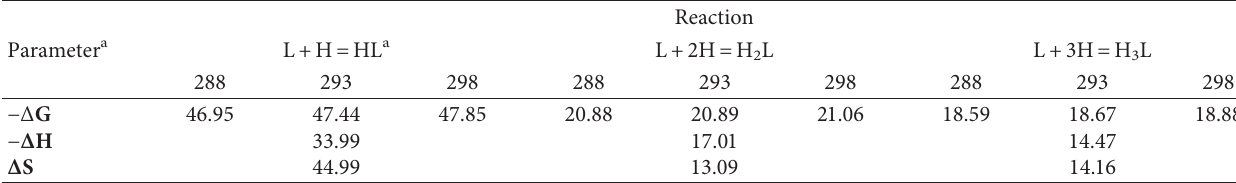
� 0.1mol · dm − 3 NaNO 2 O (V/V) solution at I 3 .